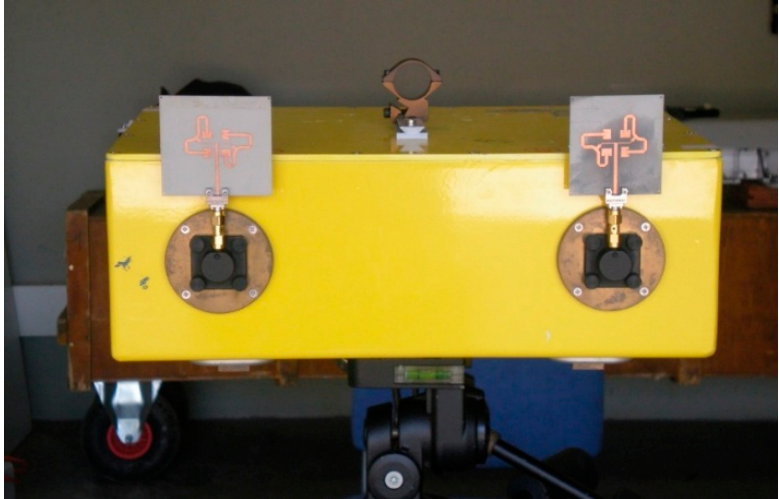
Figure 5. Photo of the two circular polarized antenna arrays mounted on the Ibis-S sensor. To the left is the LHCP and to the right is the RHCP